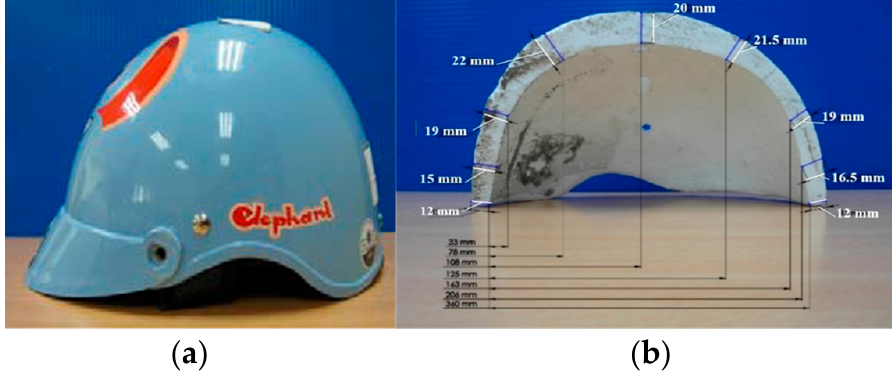
Figure 1. (a) A child motorcycle helmet sold in Thailand ( b ) the half section of the inner